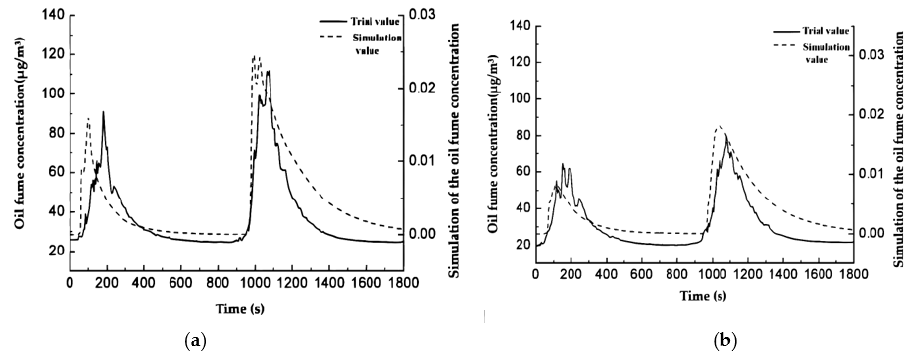
Figure 9. The comparison of the oil fume concentration between the simulation result and the experimental data: ( a ) Test point result of No. A; ( b ) Test point result of No. B.